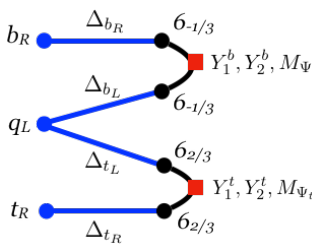
Figure 2 . The 2-site construction in the fermion sector with the Left-Right (LR) structure based on the SO(6) = SO(4) (cid:2) SO(2)